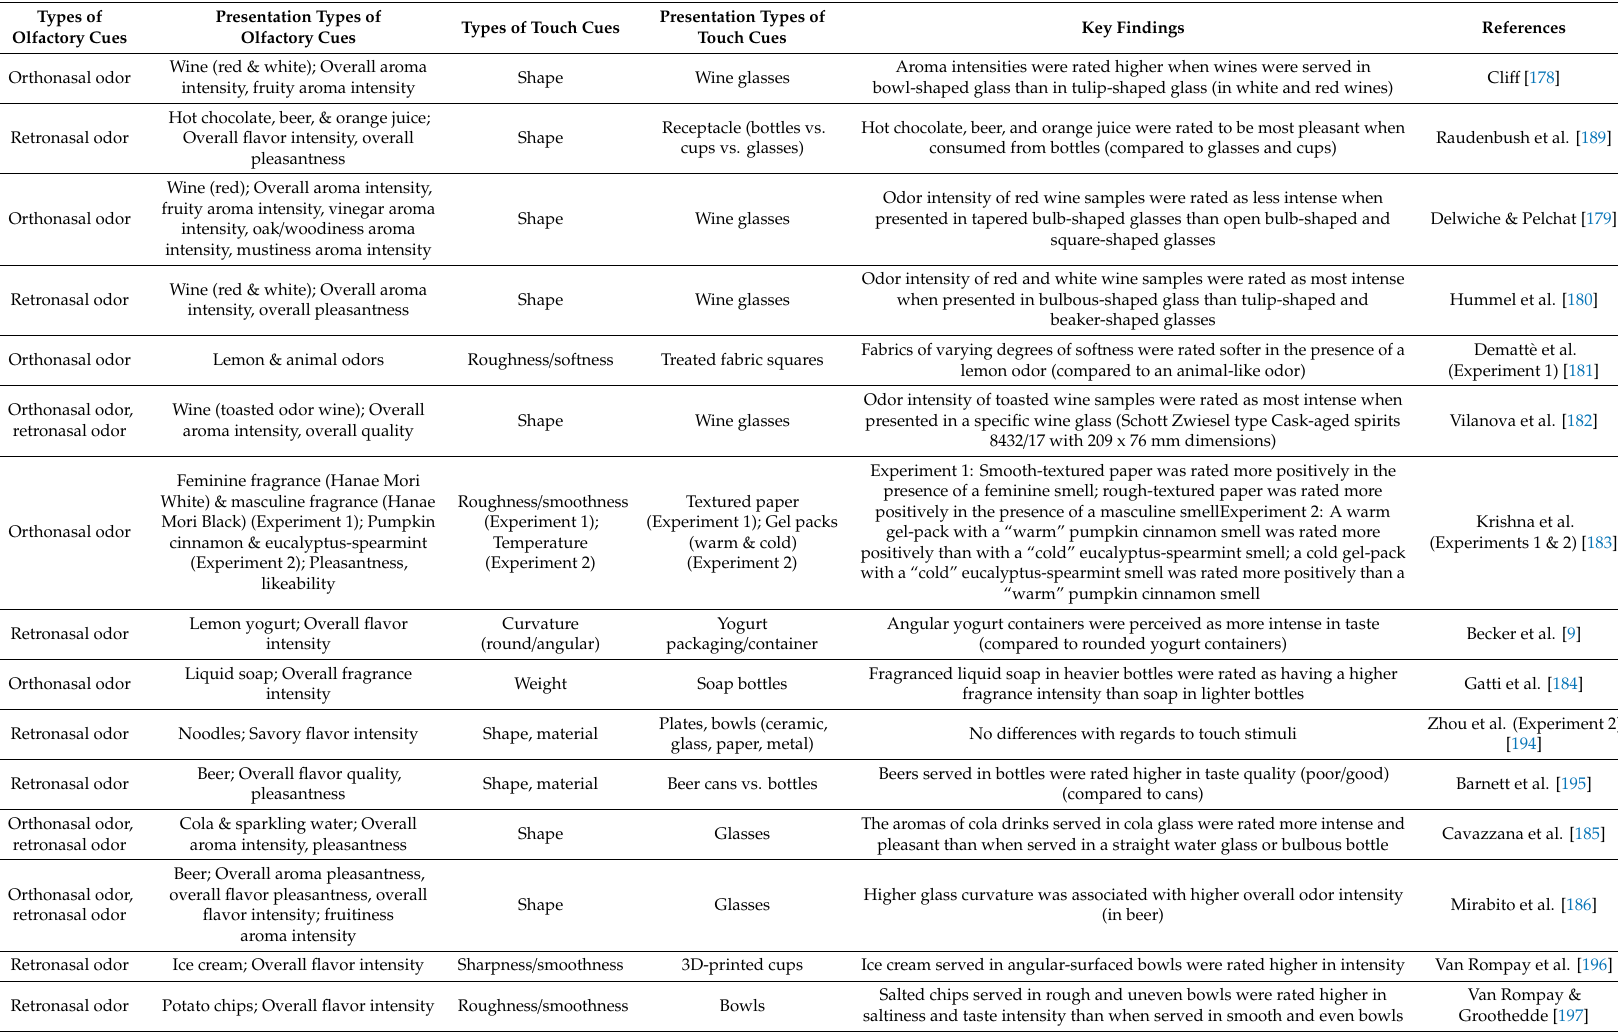
Table 3. The summary of findings regarding cross-modal associations between olfactory and hand-feel touch